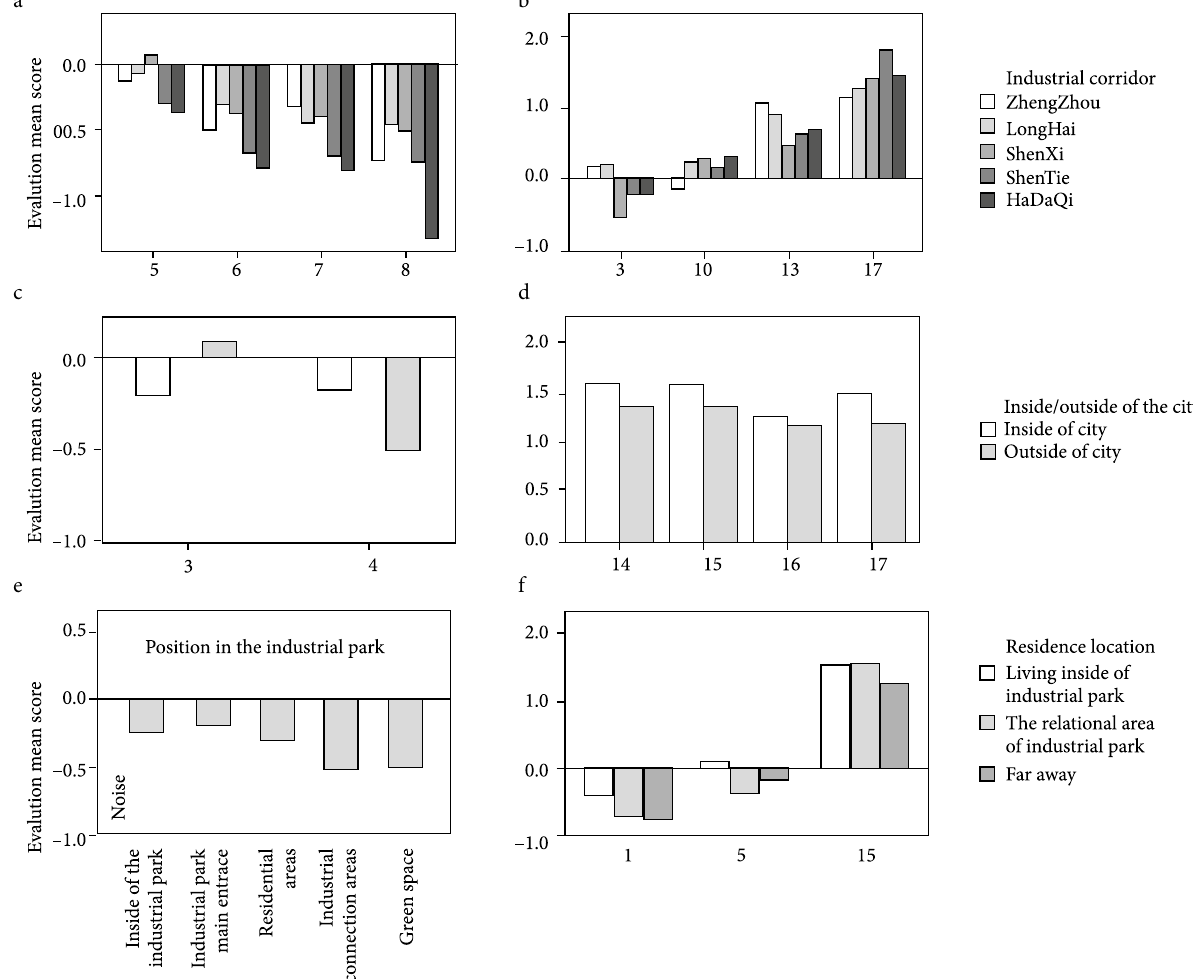
Fig 9. Mean evaluation scores with different contextual factors Note: The digital codes shown in Table 2 and